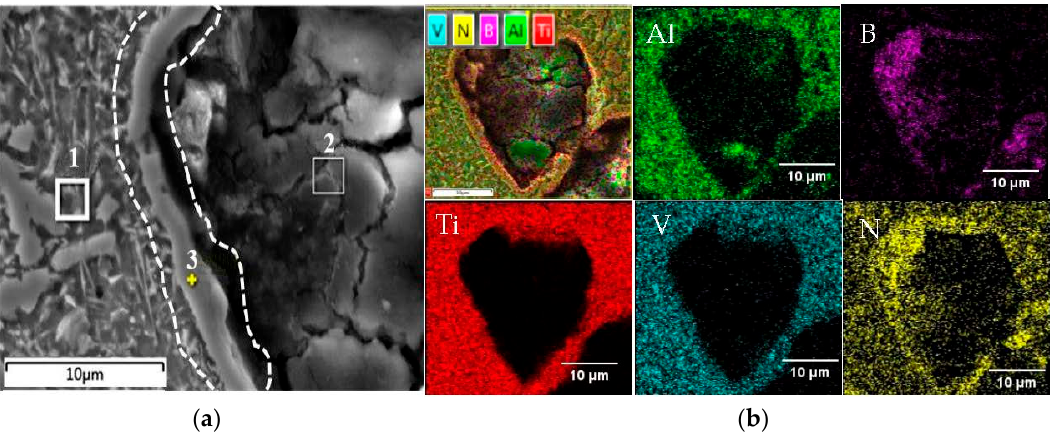
Figure 5. Images of SEM and EDS: ( a ) SEM image at the interface of a cBN particle; ( b ) element mapping of a cBN particle in the composite coating. Table 2. Elemental concentration of the selected areas of the cBN/Ti6Al4V interface.